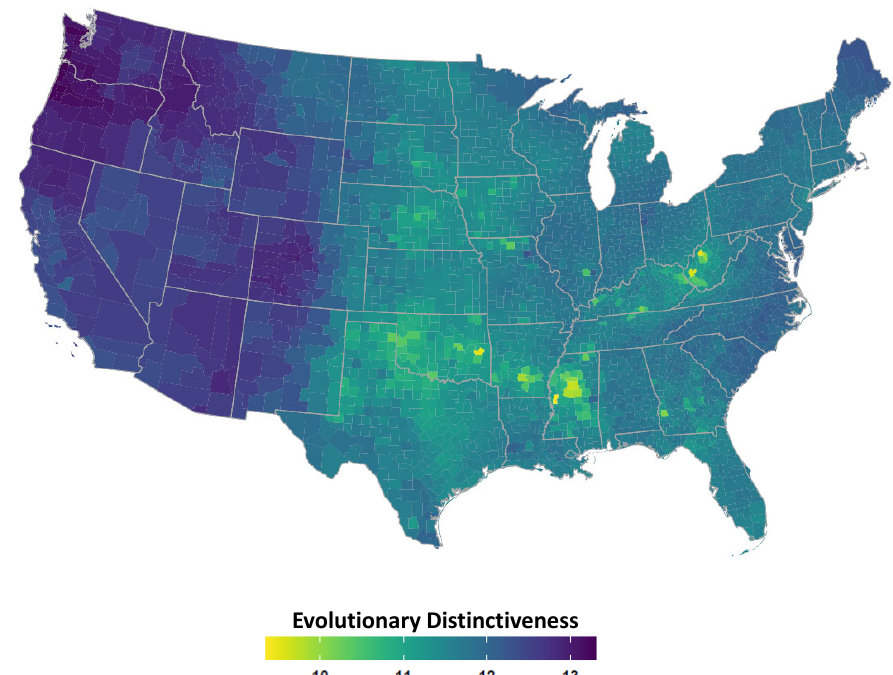
Figure A11. Static avian evolutionary distinctiveness. Evolutionary distinctiveness covariate under assump- tion of a static species pool (May–August). Covariate reflects degree of species isolation on the phylogeny or the average distance of a species to all other species in the community. Mapped counties are color coded according to legend at bottom to indicate increased evolutionary distinctiveness with darker